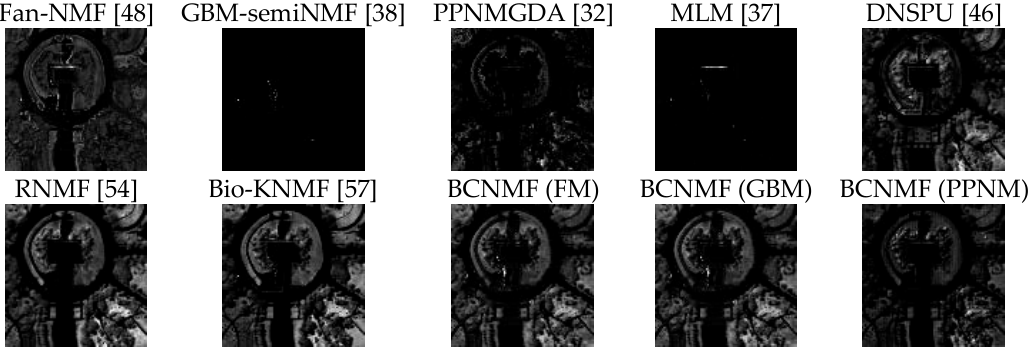
Figure 19. The differences in trees’ abundance maps between the fully constrained least squares (FCLS) and nonlinear spectral unmixing algorithms.